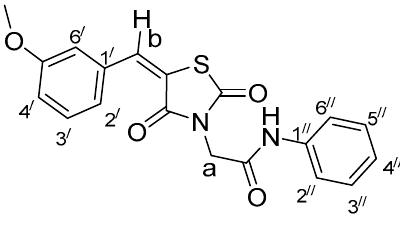
Figure 1. Structure of compound 4b .